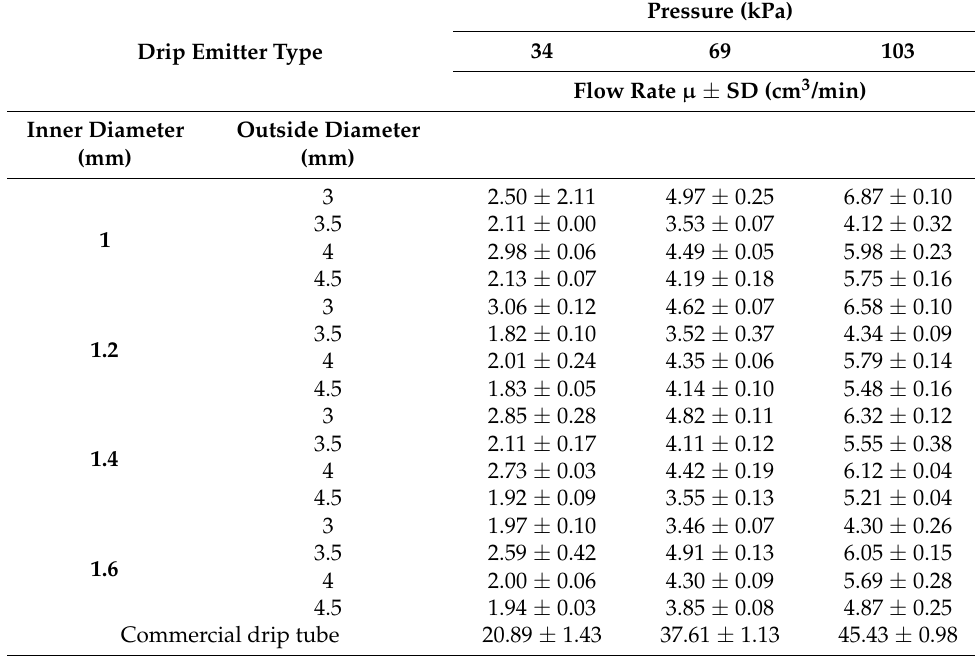
Table 2. Descriptive statistics of flow rate commercial drip emitter with new drip emitter for the lab experiment.